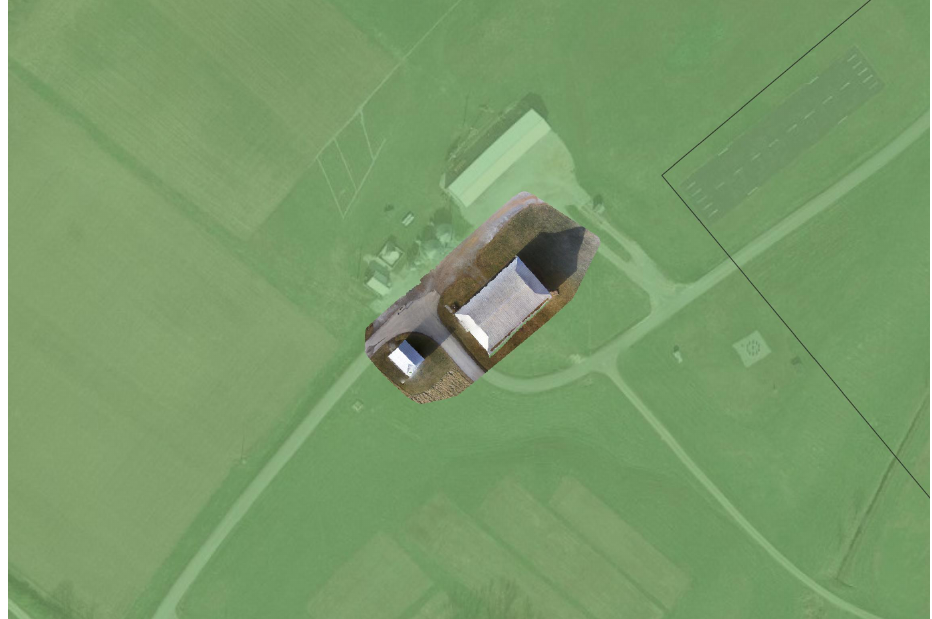
Figure 9. A 3D reconstruction orthophoto produced from drone imagery captured at Kentland Farm overlaid on satellite imagery and cadastre data in